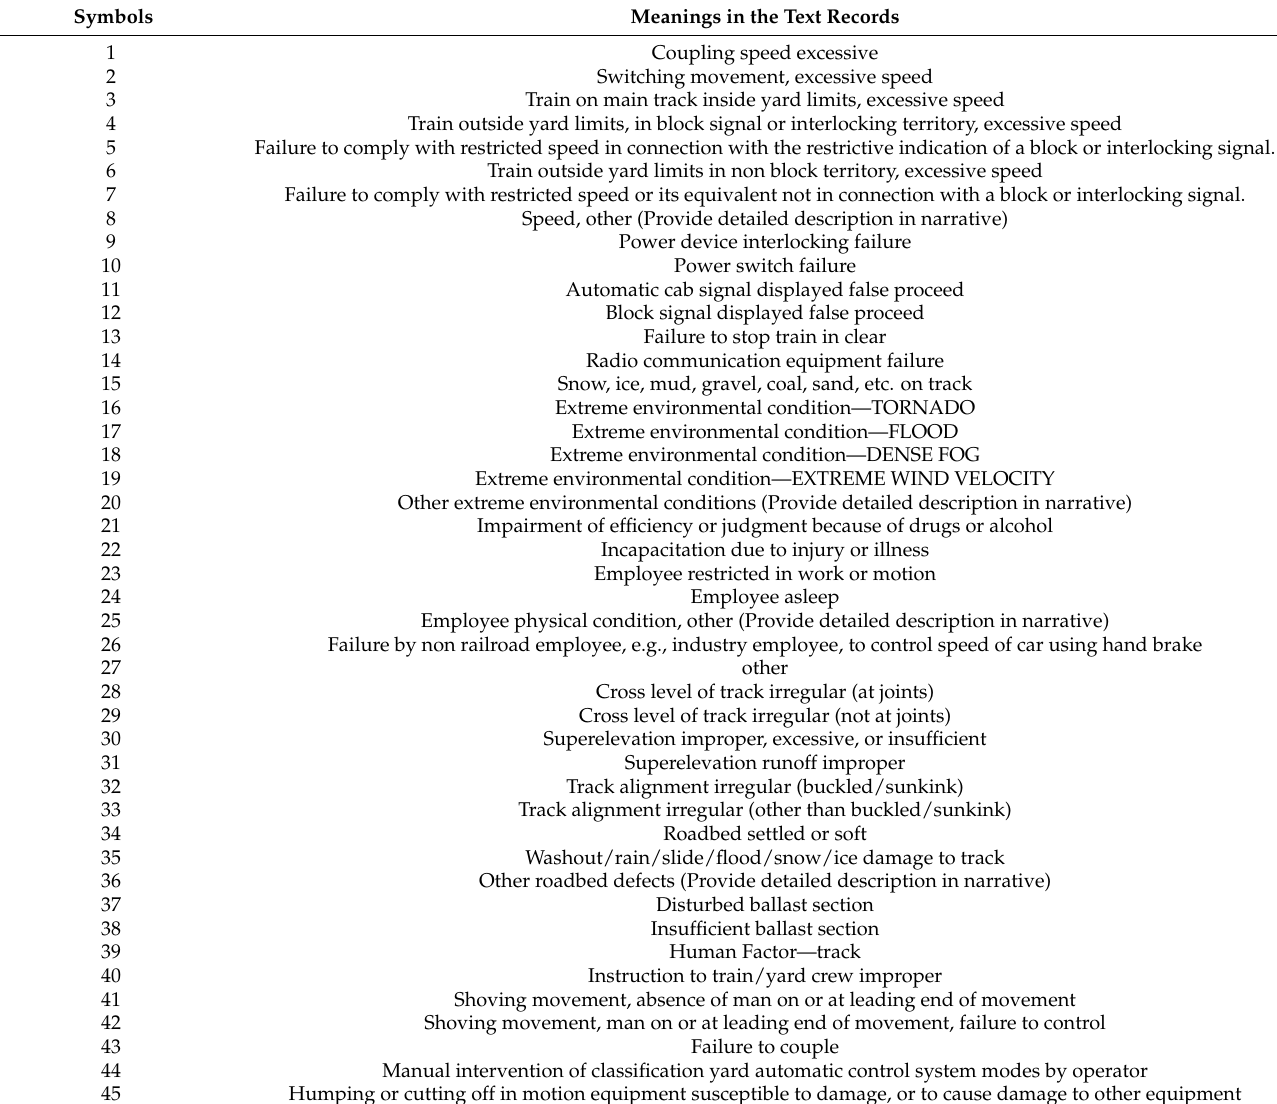
Table A2. The following symbols are used in Figure